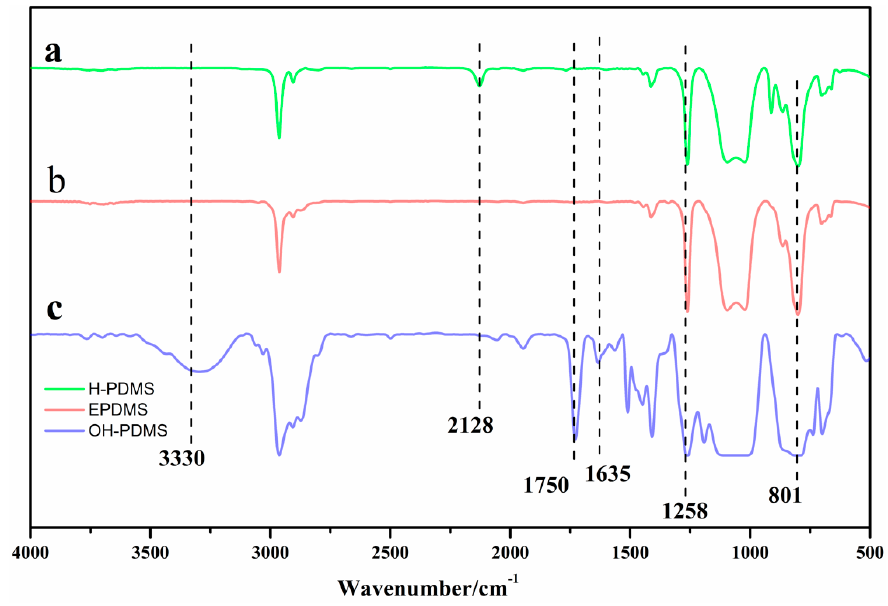
Figure 2. Fourier transform infrared (FT-IR) spectroscopy results of the intermediaries of fluorinated graft copolymer, where a is H-PDMS, b is EPDMS, and c is OH-PDMS.